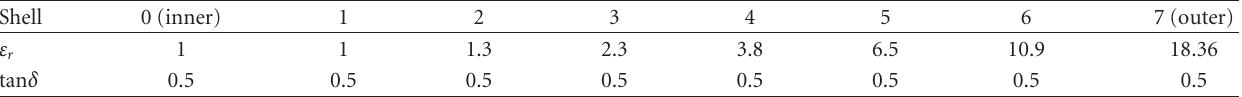
Figure 2: Sinuous antenna over a substrate comprising concentric dielectric cylinders of varying permittivity. Table 1: Material